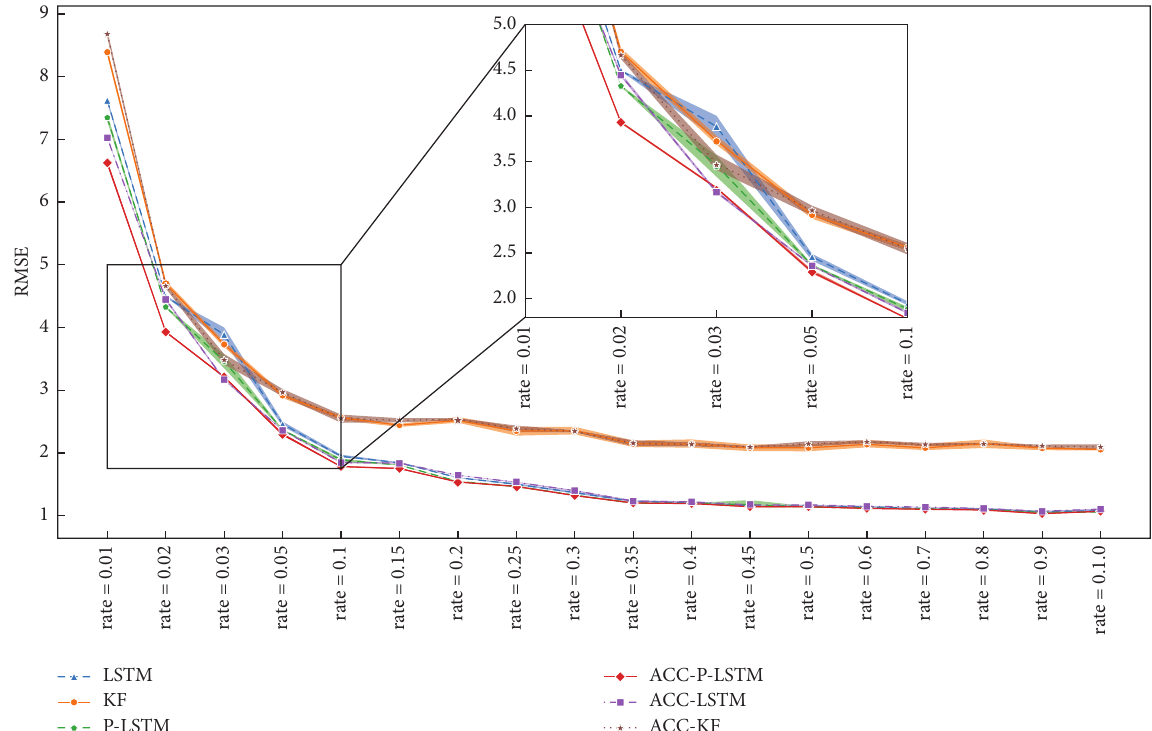
Figure 5: RMSE comparison of estimation results of various models under different penetration rates. Note: LSTM � Long Short-Term Memory; ACC-P-LSTM � LSTM model using KNN filling with fusion acceleration and penetration rate estimation; P-LSTM � LSTM model using penetration rate estimation; ACC-LSTM � LSTM model using KNN filling with fusion acceleration; ACC-KF � Kalman Filtering using KNN filling with fusion acceleration; KF � Kalman Filtering; and RMSE � Root Mean Square